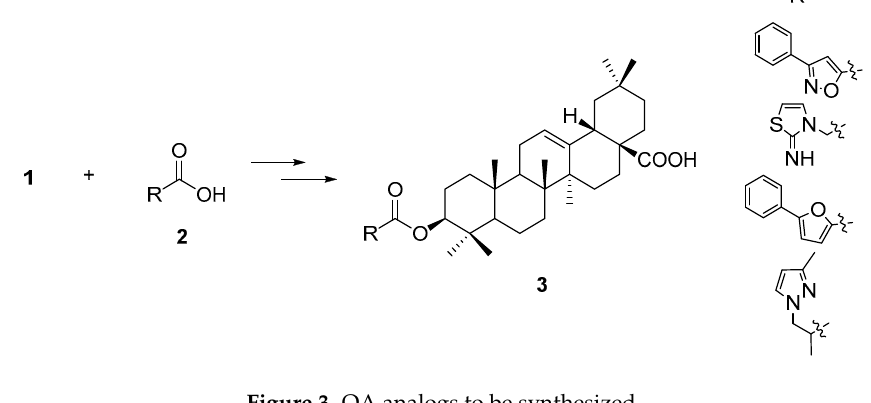
Figure 3. OA analogs to be synthesized. Table 1. The predicated p K i values and antagonistic activities of oleanolic analogs.